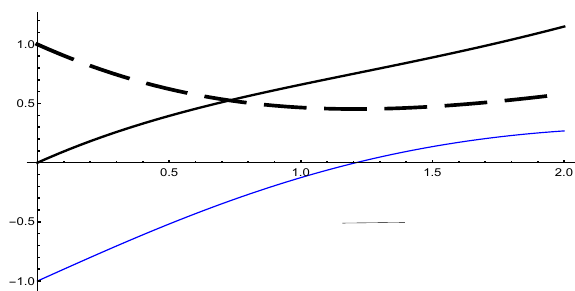
Figure 1. Graph of the function and its first and second derivatives. The black line shows the function, the dashed line shows the first derivative, and the blue line shows the second